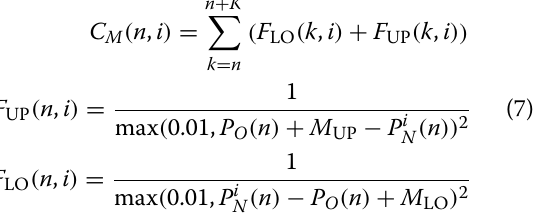
of a candidate line is steep, this term becomes